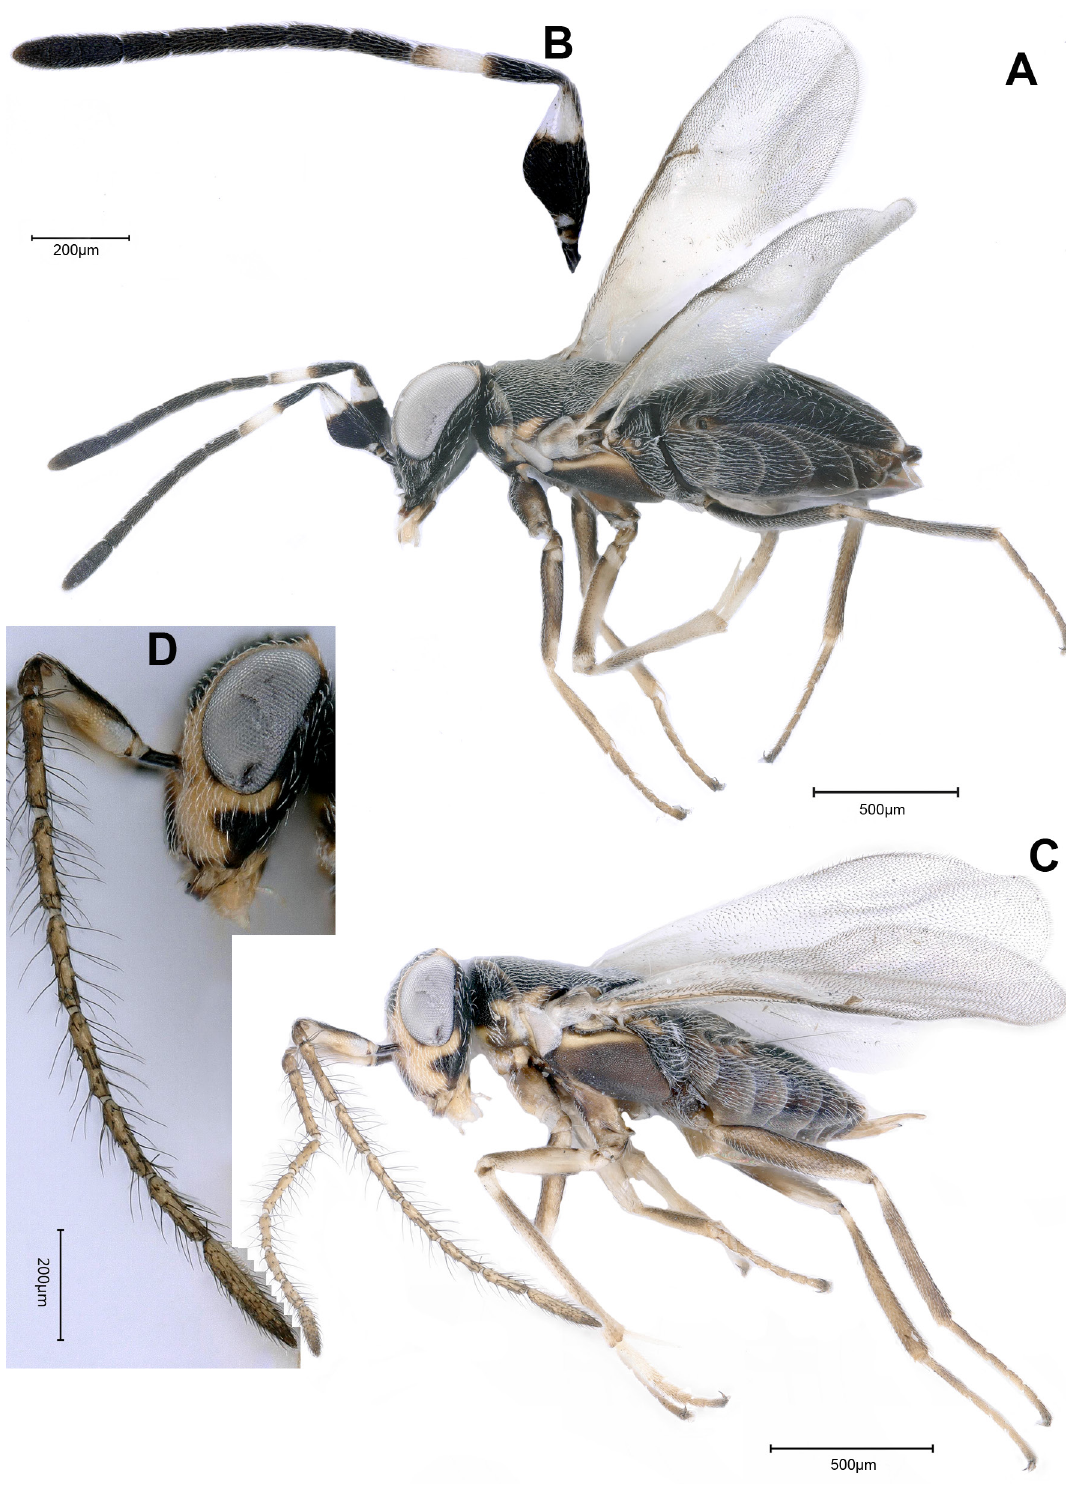
Fig. 1. Anagyrus near alienus Japoshvili, 2012. A . Female body in lateral view. B . Right antenna of female. C . Male body in lateral view. D . Left antenna of